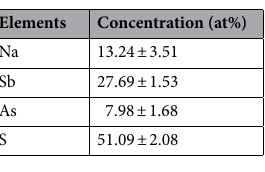
Table 1. EDXS quantification of bulk gerstleyite.